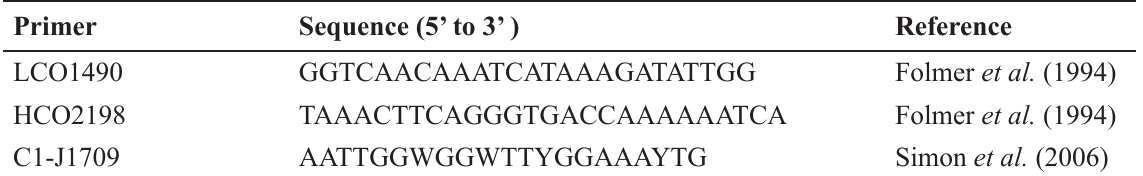
Table 2. Polymerase chain reaction primers used to sequence mtCOI genes of Apatidelia spp.